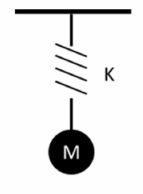
Figure 4. Harmonic